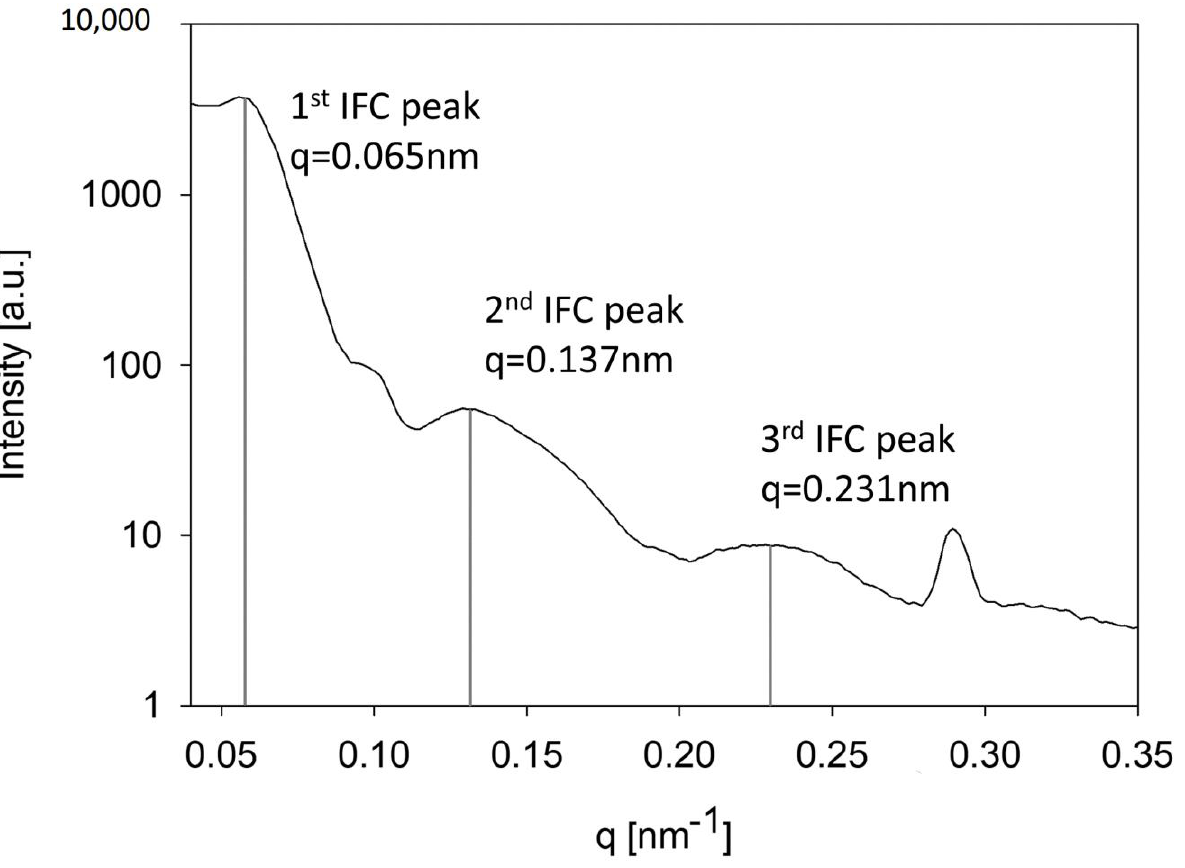
Figure A1. Full range of I(q) plot for IFC: The diffuse orthogonal peak is seen to have a fundamental repeat in the range of ~88–100 nm (see also Figure 3), with the lowest order (IFC; n = 1) partly masked due to the scattering of the direct beam from the beam-stop. The three vertical lines indicate the n = 1, 2 and 3 orders of the IFC peak; Arrows indicate the locations of the 1st, 2nd and 3rd order meridional collagen peaks. The 3rd meridional collagen peak is clearly visible just below 0.30 nm −1 , while the positions for the 1st and 2nd meridional peaks are indicated via arrows.